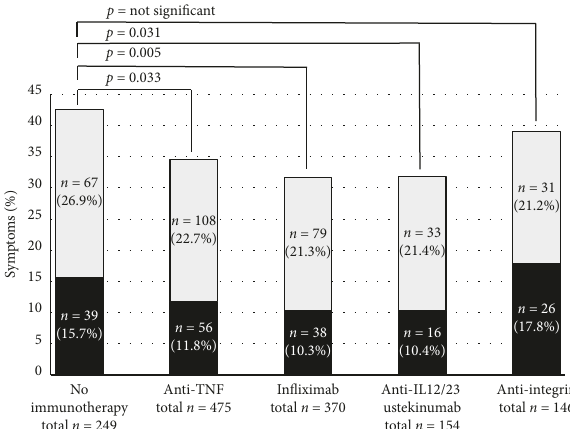
Figure 2: Symptoms of respiratory tract infections in IBD patients: moderate in grey (cough, rhinitis, and sore throat) and severe in black (fever, chills, and anosmia), in patients without immuno- therapy or according to their immunotherapies. Patients with anti- TNF, infliximab, and ustekinumab treatment show significant less respiratory symptoms compared to those with no immunother- apies ( p < 0 .